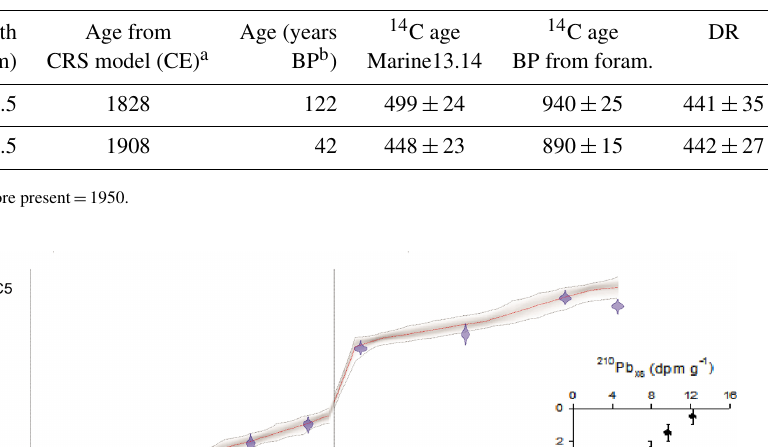
Table 2. Reservoir age estimation considering the 210 Pb age determined with the CRS model (McCaffrey and Thomson, 1980) at selected depth sections of the core as compared with 14 C ages (years BP) from the Marine13.14 curve (Reimer et al., 2013) according to Sabatier et al. (2010).